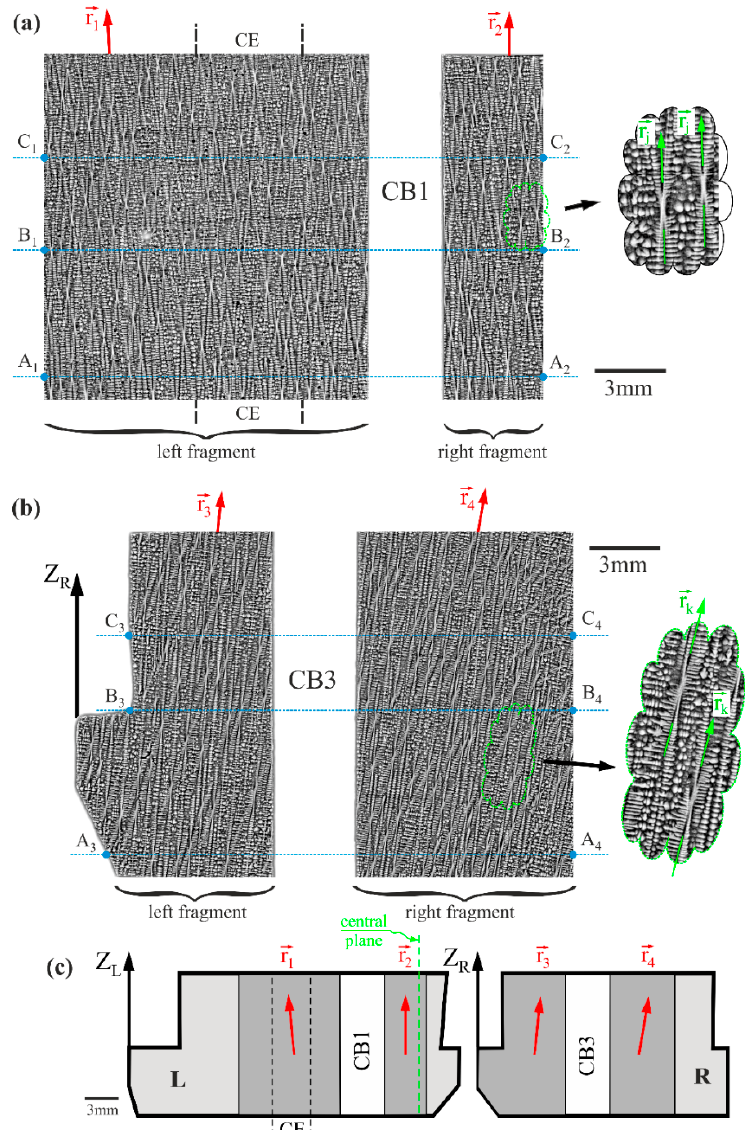
Figure 2. SEM macro images of the dendritic structure visualized on the left and right fragments of surface L ( a ) and surface R ( b ), as well as the schema of the “fanning effect” of primary dendrite arms ( c ). BSE technique. CB1, CB3—cooling bores, CE—continuer extension area. The inserts on the right show exemplary hourglass-like shapes that visualize single dendrites on the L and R surfaces. → → → → r 1 − r 4 and r j , r k —unit vectors that define the growth direction of primary dendrite arms and axes of hourglass-like shapes, respectively.